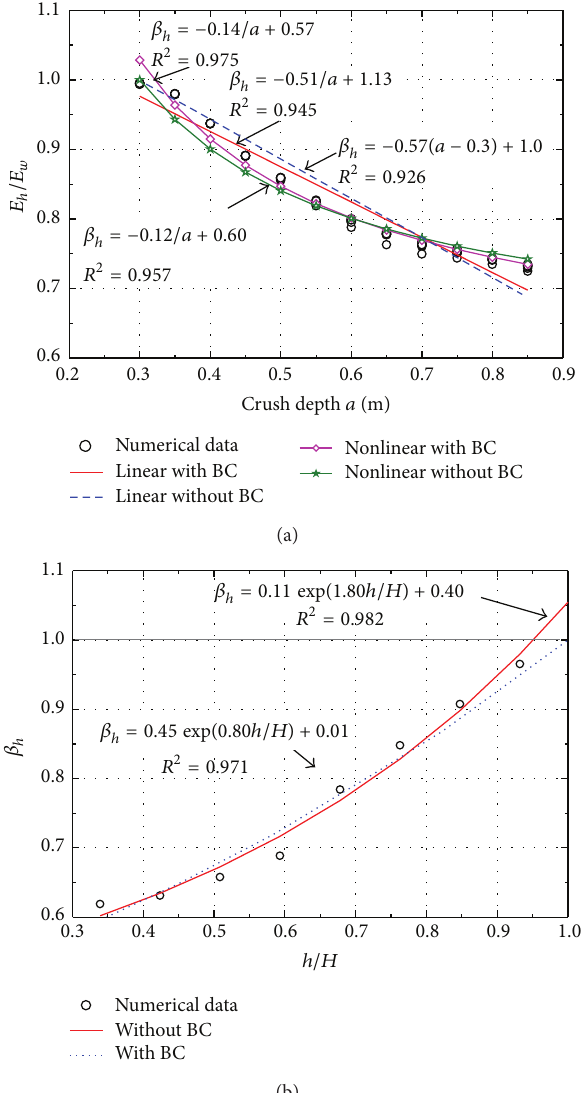
Figure 17: Phase analysis of 10,000 DWT ship bow: (a) Phase II; (b) Phase